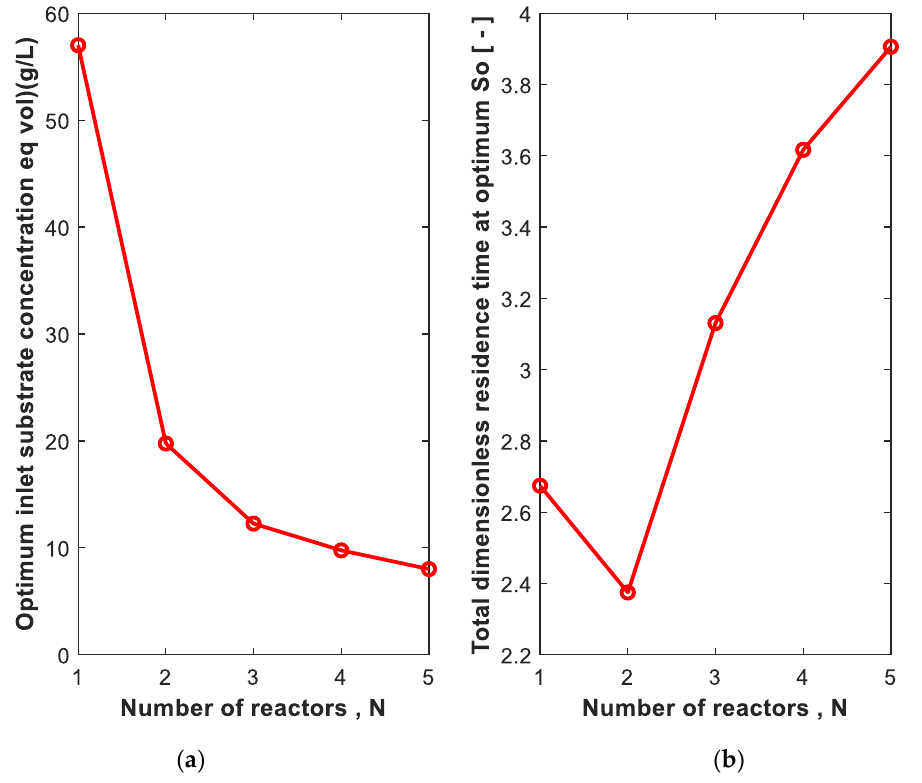
Figure 10. The substrate concentration in the first reactor ( a ) at which the total equal dimensionless residence time is minimum ( b ) for N reactors in series. Substrate conversion: 99%. 𝑋 𝑜 = 0.01 g/L. 𝑃 𝑜 = 0. N = 1 is shown for comparison.